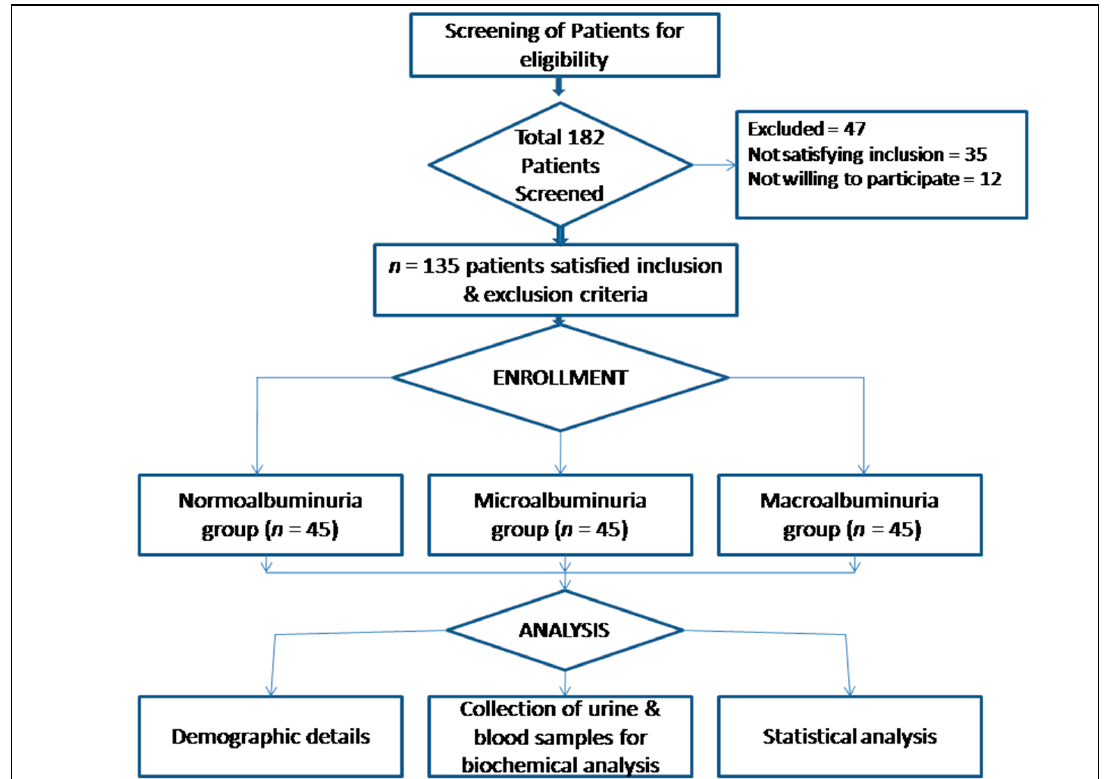
Figure 1. Schematic presentation of flow of participants.